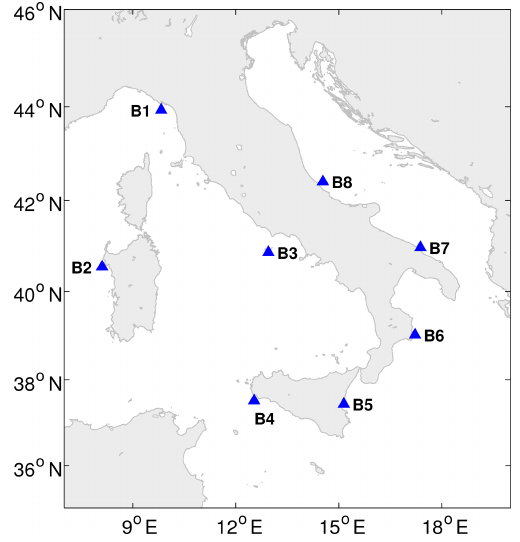
Figure 1. Study area and investigated locations with their respective